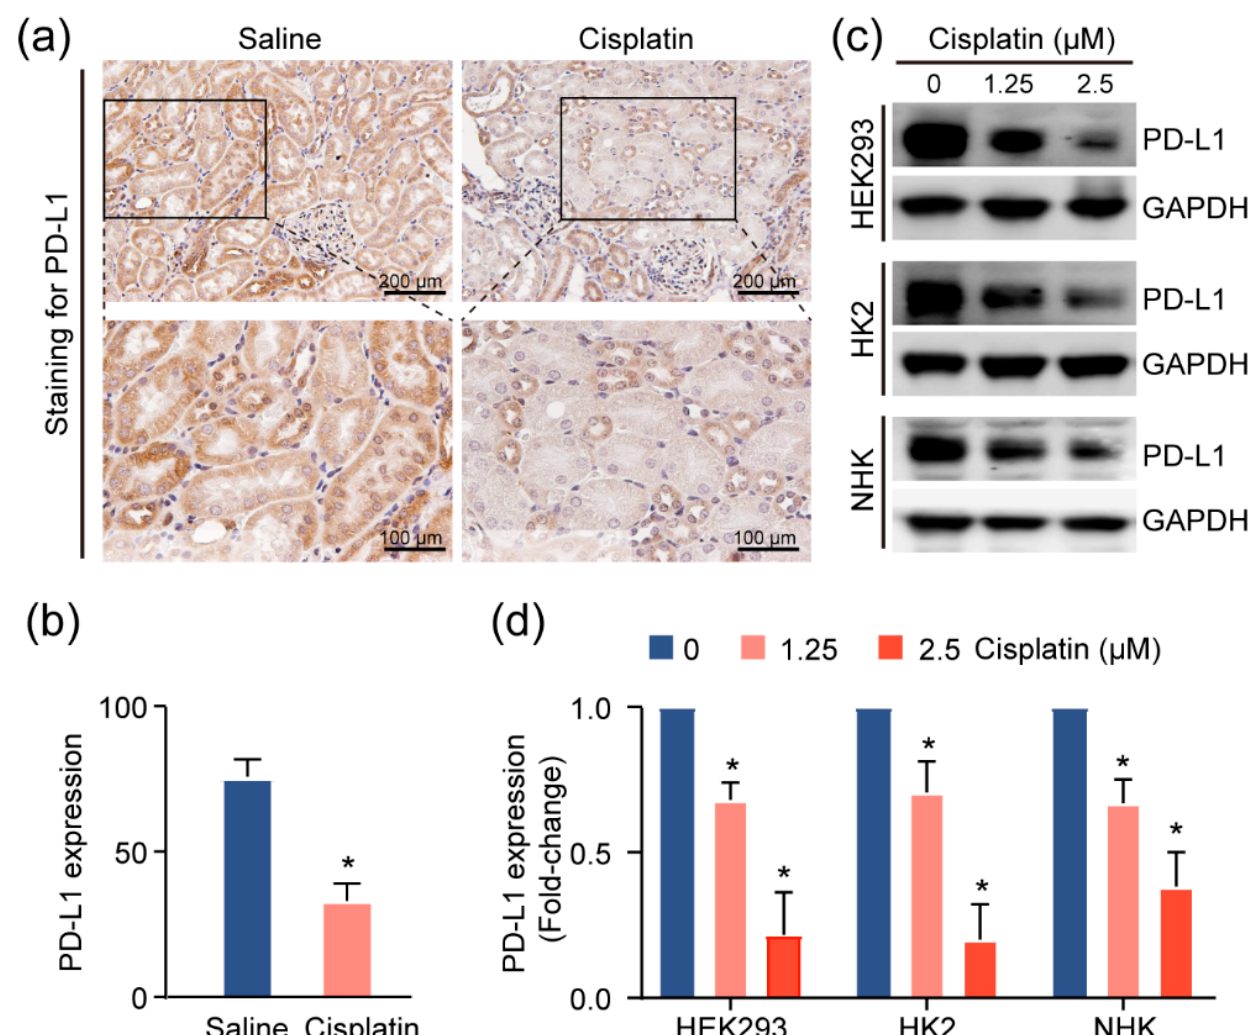
Figure 4. PD-L1 dysregulation in renal epithelium upon kidney injury. ( a ) Representative images for PD-L1 expression levels and quantification, ( b ) of PD-L1, assessed by immunohistochemical (IHC) staining in cisplatin-exposed kidneys ( n = 4) using anti-PD-L1 monoclonal antibody. Positive staining is quantified (mean ± SD, * p < 0.05 versus saline group). ( c ) Western blot analysis of kidney cell lines treated with escalating doses of cisplatin and quantification, ( d ) for PD-L1 levels in cells upon treatment with cisplatin for 24 h. Normalized expression levels of PD-L1 from three separate experiments are shown ( * p < 0.05).